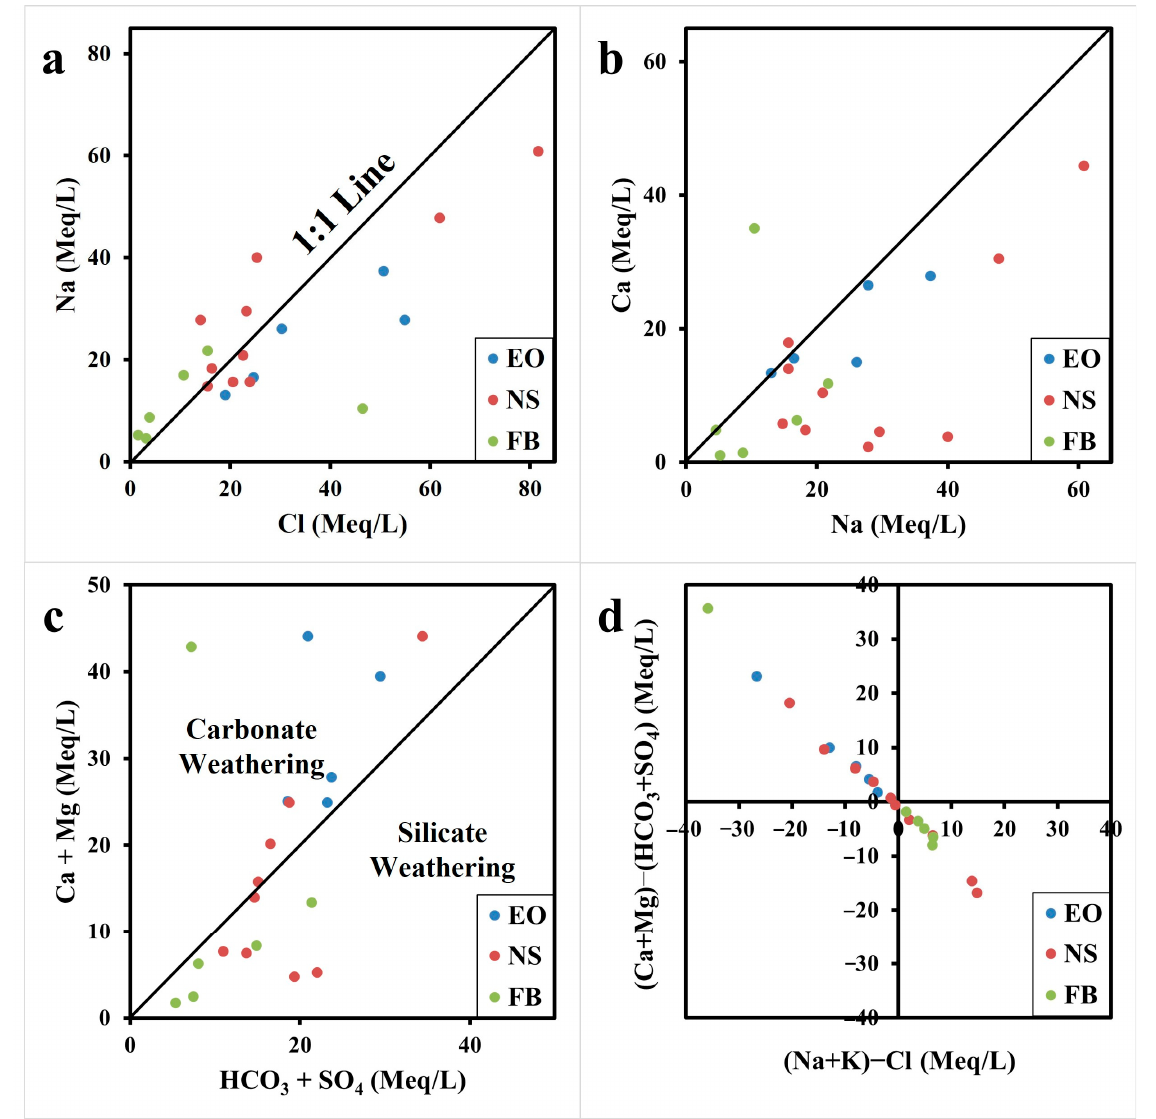
Figure 6. Plots of the EOC, NS, and FB groundwater samples on scatter diagrams: ( a ) Na + vs. Cl − ; ( b ) Na + vs. Ca 2+ ; ( c ) (Ca 2+ + Mg 2+ ) vs. (HCO 3 − + SO 42 − ); ( d ) (Ca 2+ + Mg 2+ )-(HCO 3 − + SO 42 − ) vs. Na + + K + -Cl − .